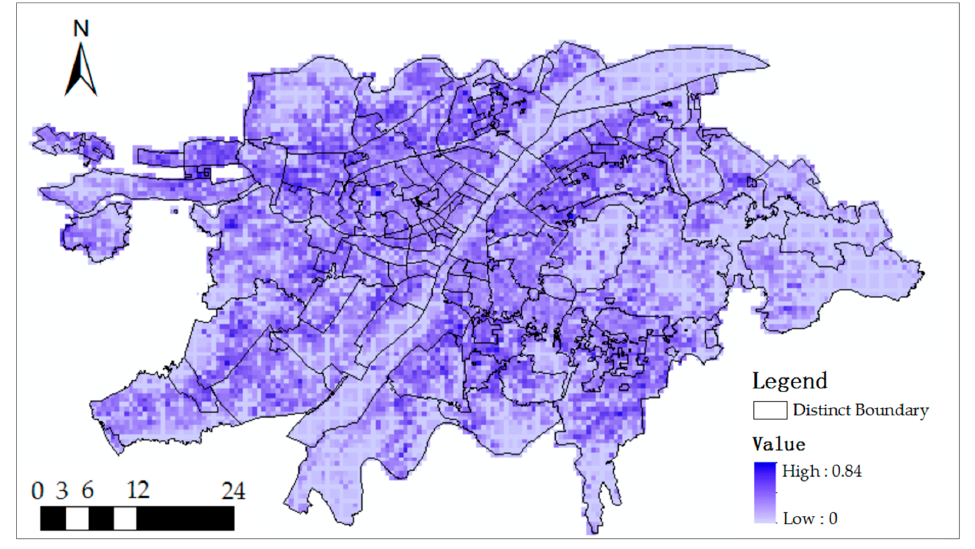
Figure 8. Ratio of estimation errors.